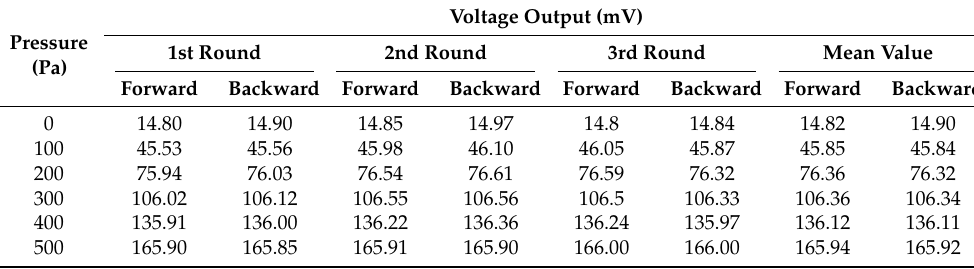
Table 2. Calibration data for the improved diaphragm II.